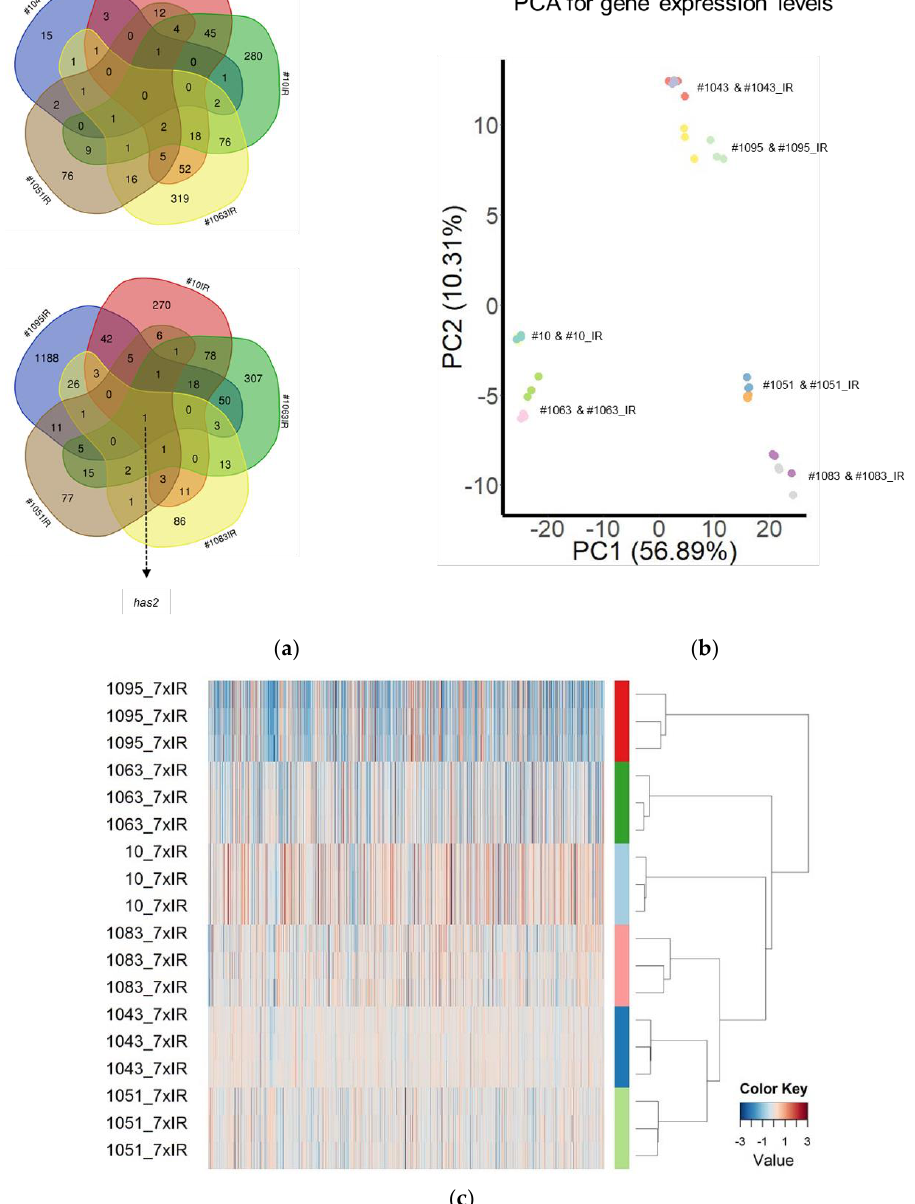
Figure 5. Diverse patterns of transcriptomic changes induced by hypofractionated radiation. ( a ) Venn diagram showing the overlap in differentially expressed genes (DEGs) identified in different GSC/GSC_IR pairs; ( b ) Principal component analysis of gene expression compared between isogenic GSC and GSC_IRs. Each line was analyzed in triplicate. Values aligned with axes show proportion of variance in percent for principal components 1 (PC1) and 2 (PC2), respectively; ( c ) Heatmap for log 2 fold change (FC) of gene expression levels calculated for 1989 significantly altered genes (FDR < 0.05, log 2 (FC) ≥ 1). The most common DEG identified in five out of six pairs analyzed was gene has2 coding for hyaluronan synthase 2, an enzyme implicated in the regulation of cell invasion/migration/adhesion